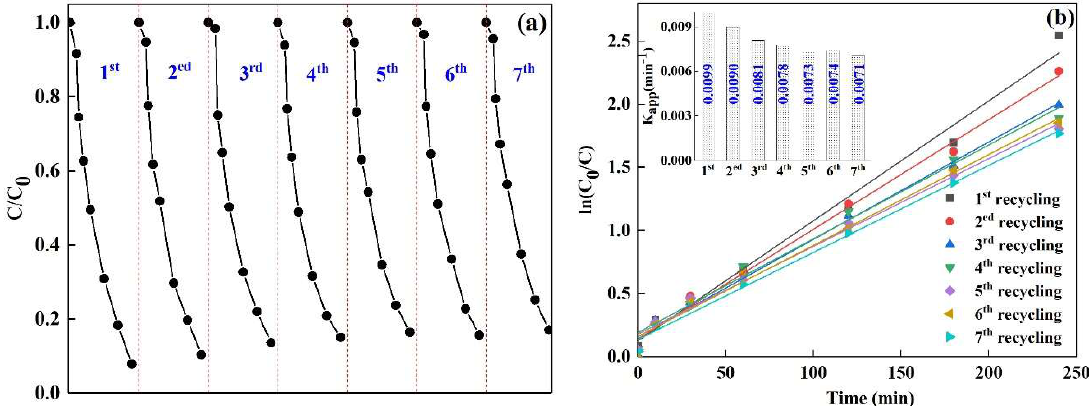
Figure 6. Total Organic Carbon (TOC) removal efficiency of the DS photodegradation solutions in Figure 7. ( a ) Photodegradation efficiency of DS; ( b ) plots of ln(C 0 /C) versus irradiation time different photocatalytic systems. over CuBi 2 O 4 / β -Bi 2 O 3 (1:2.25, 600 °C) under different recycling runs. The illustration in ( b )